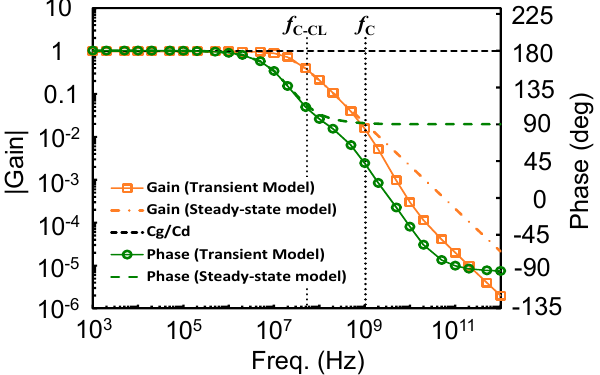
Figure 11. The frequency response of the SET inverting amplifier with a load capacitor C L = 30 aF (10 C Σ ) operating at a drain current I d = 26.4 pA, gate voltage V gs = 53.4 mV [0.33] (center of the descending side of the CD) and T = 15.5 K [0.05].